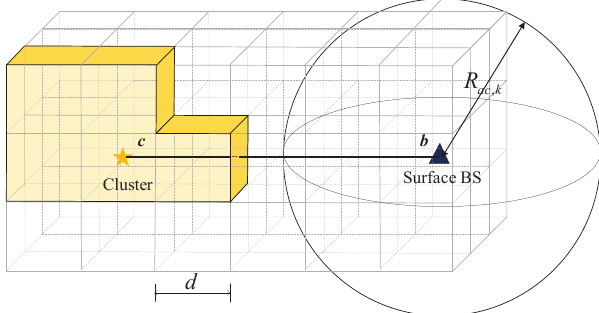
Figure 4. The geometry of underwater MI-assisted acoustic cooperative MIMO networks in multi-hop